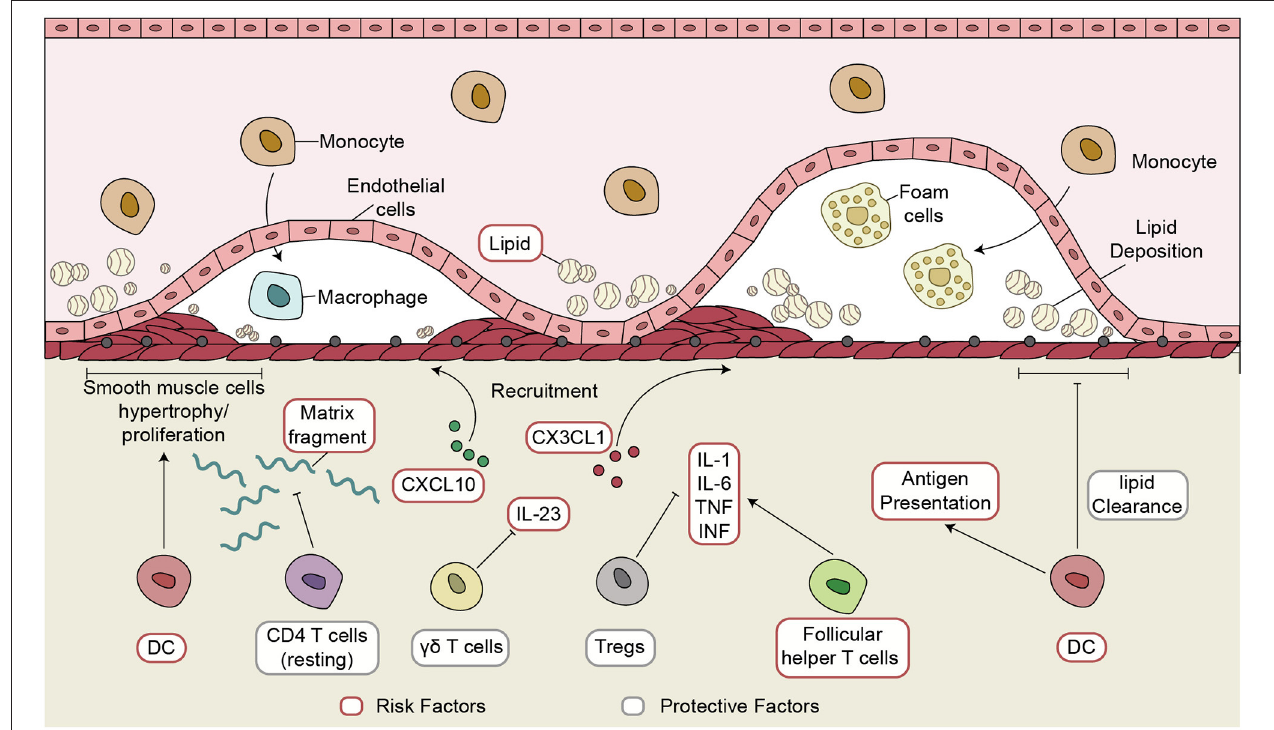
FIGURE 6 | The possible inflammatory immune microenvironment in CAD. CAD, coronary artery